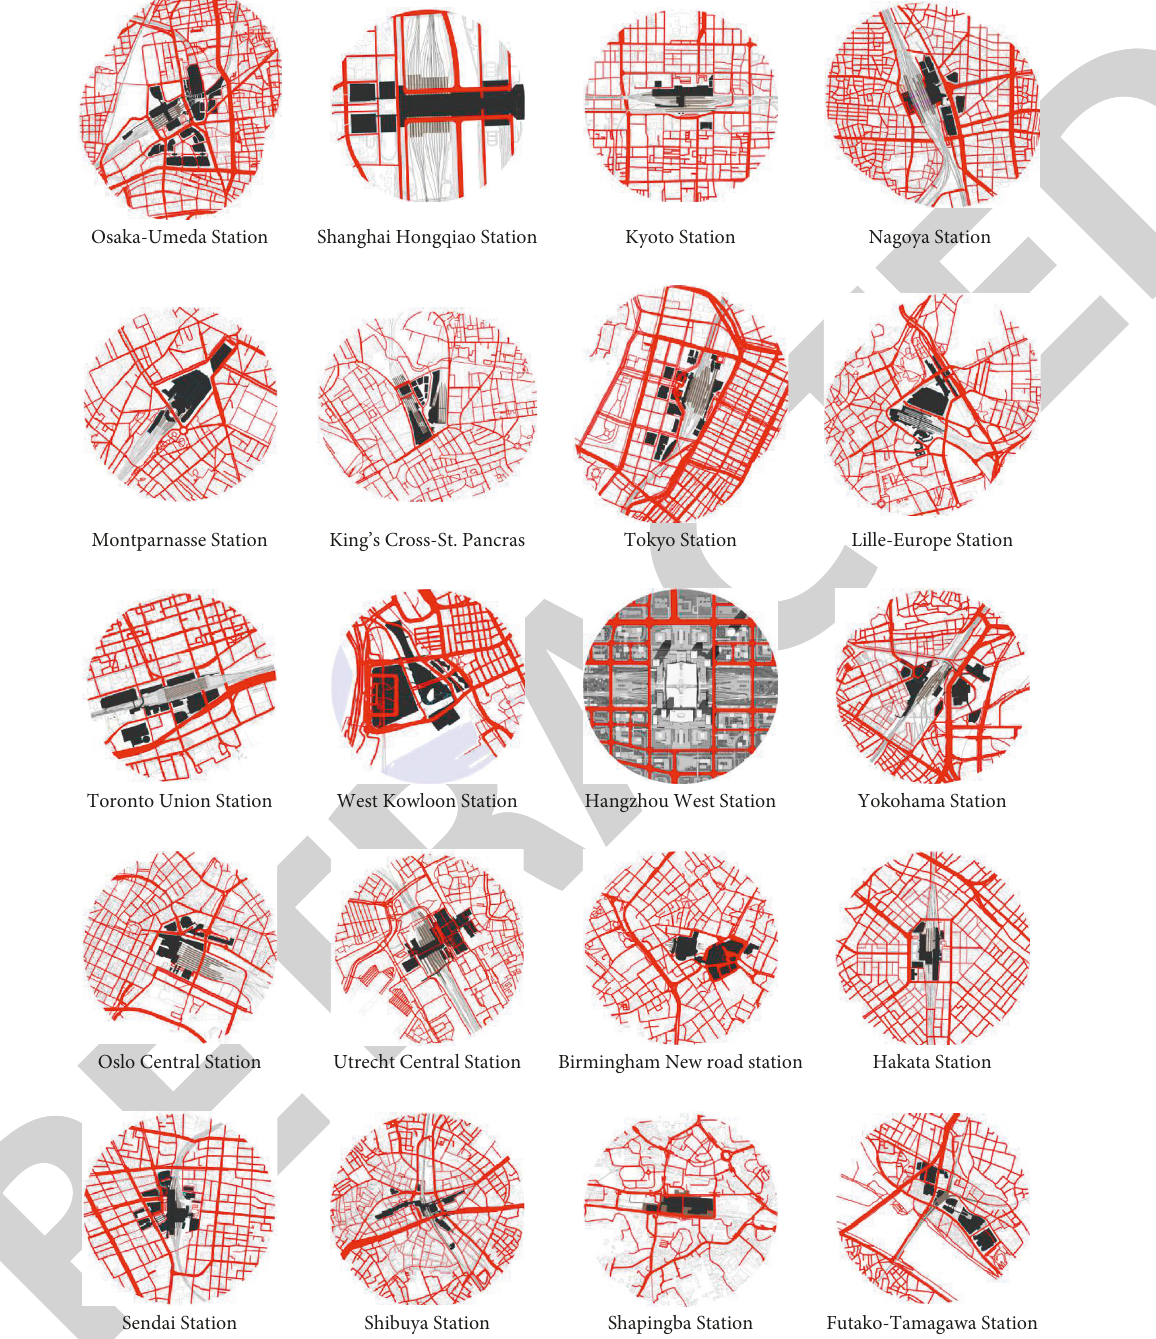
Figure 2: Network density